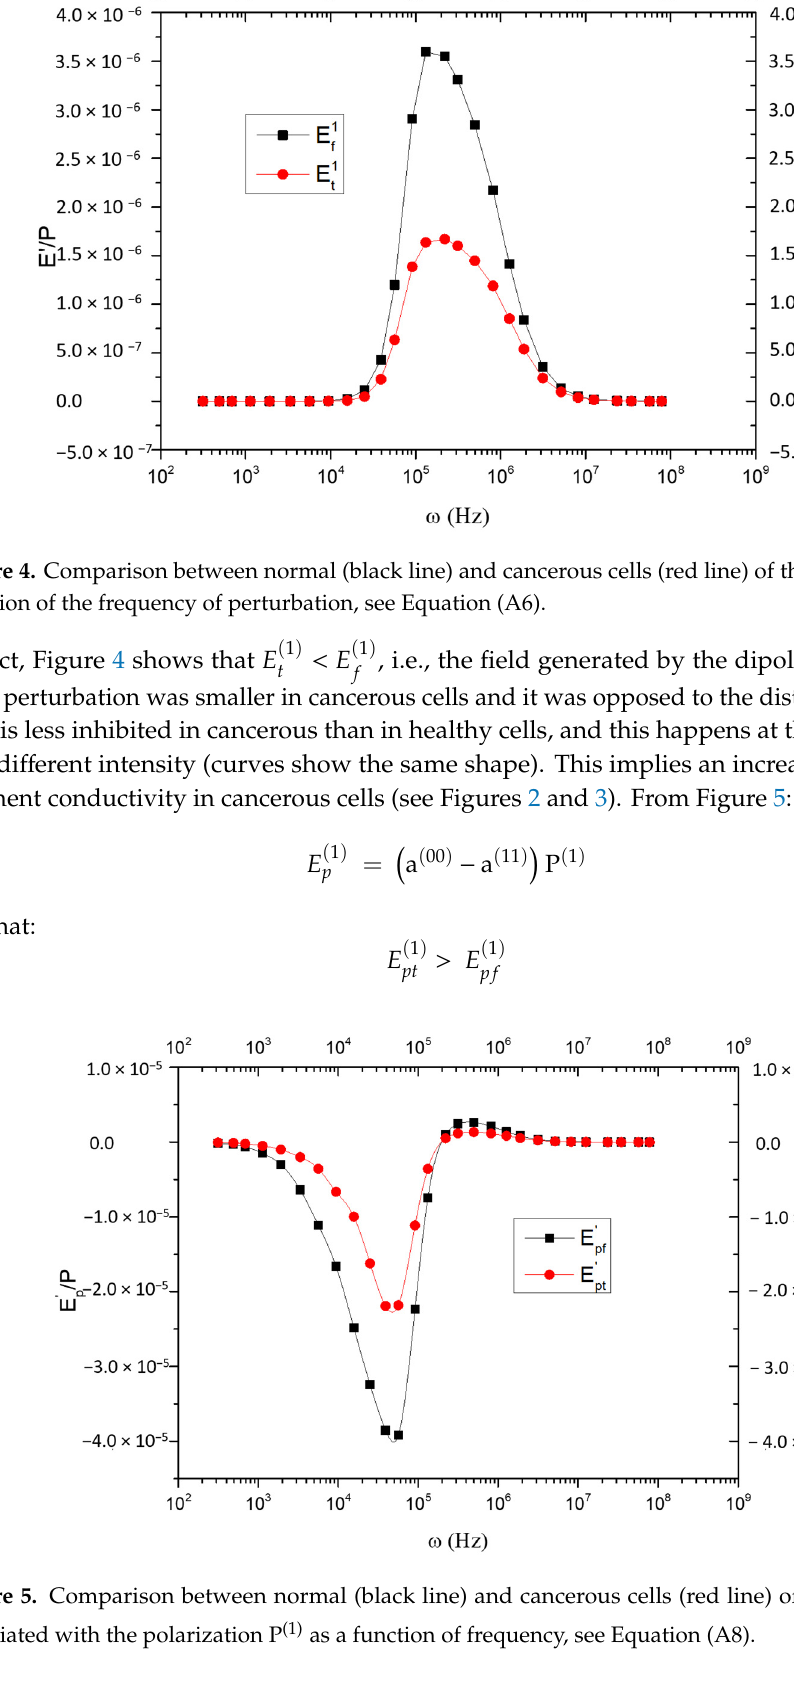
Figure 5. Comparison between normal (black line) and cancerous cells (red line) of the field E associated with the polarization P (1) as a function of frequency, see Equation (A8).